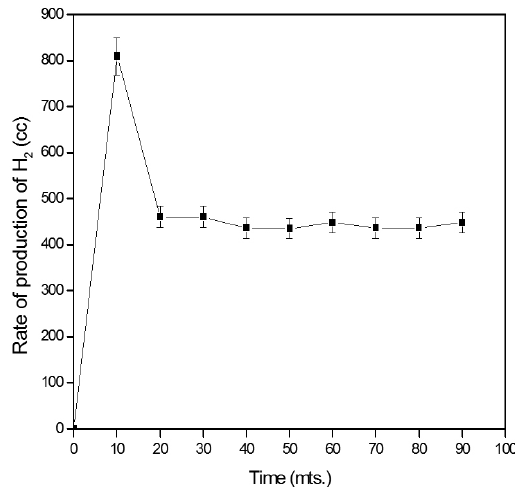
Figure 8. Influence of various cylindrical electrodes on the production of hydrogen gas: Dimensional of graphite rod: 80 × 20mm; Temperature: 303 K; Pressure: 1 atm; Electrolyte concentration: 0.03 M; Applied voltage: 12 V; Applied Current: 1.2 A; Distance between the electrodes: 2 cm.